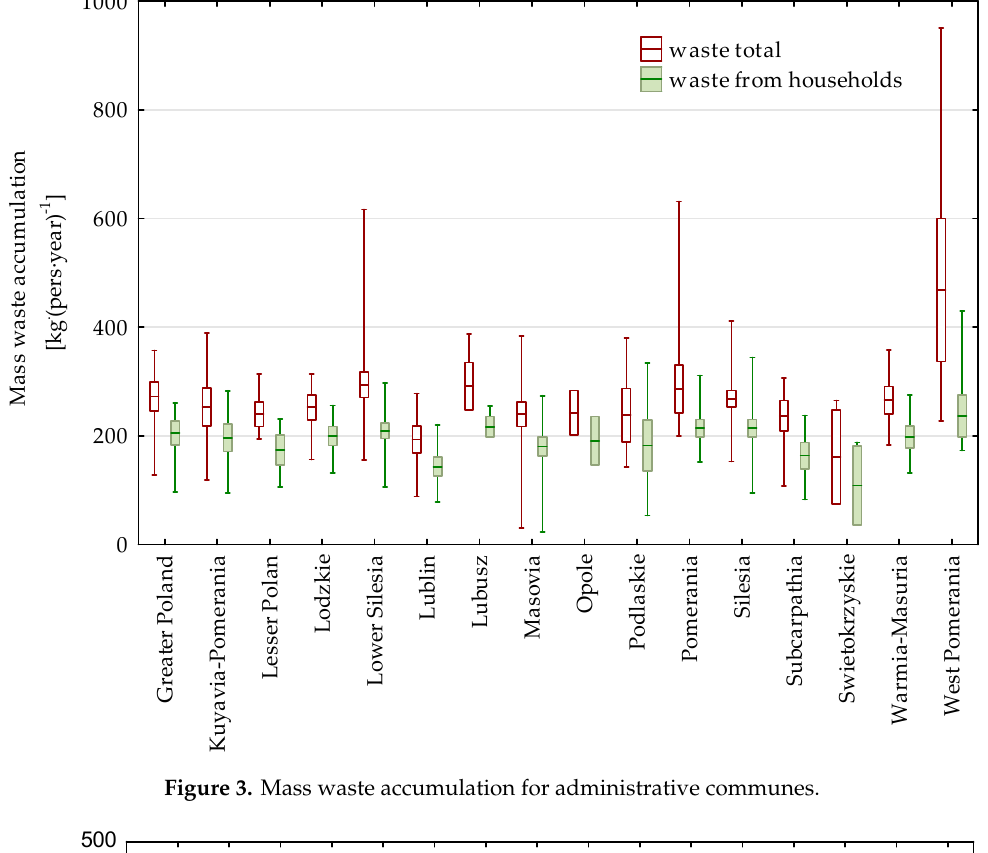
Geosciences 2019 , 9 , 458 Figure 3. Mass waste accumulation for administrative communes. Figure 3. Mass waste accumulation for administrative communes.